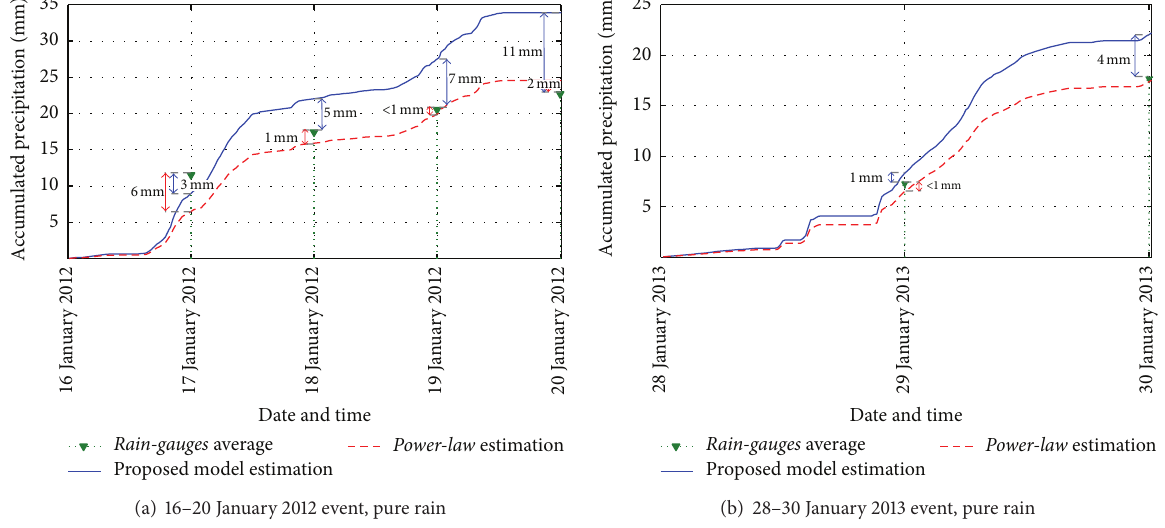
Figure 4: Accumulated precipitation between 16 January 2012 and 20-Jan-2012 (a) and the accumulated precipitation between 28-Jan-2013 and 30-Jan-2013 (b), as observed by the Rain-Gauges , as estimated by the proposed model, and as estimated by the Power-Law model. The estimateserrorsthroughoutthestormsarepresented:Itcanbeseenthatingeneral,the PowerLawModel achievedbetterestimatesthroughout the storms. However, the proposed model estimation error is